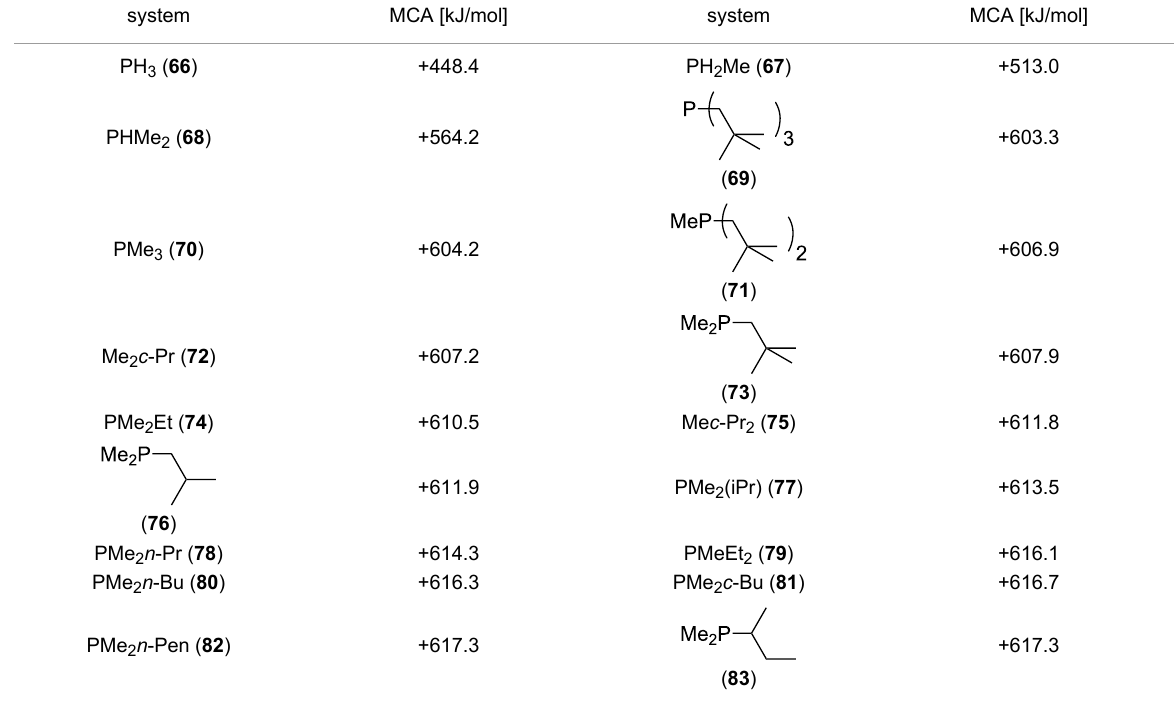
Table 2: MCA values of saturated trialkylphosphanes without heteroatoms, PPh 3 , PH 3 , PH 2 Me and PHMe 2 , ordered by increasing MCA values.